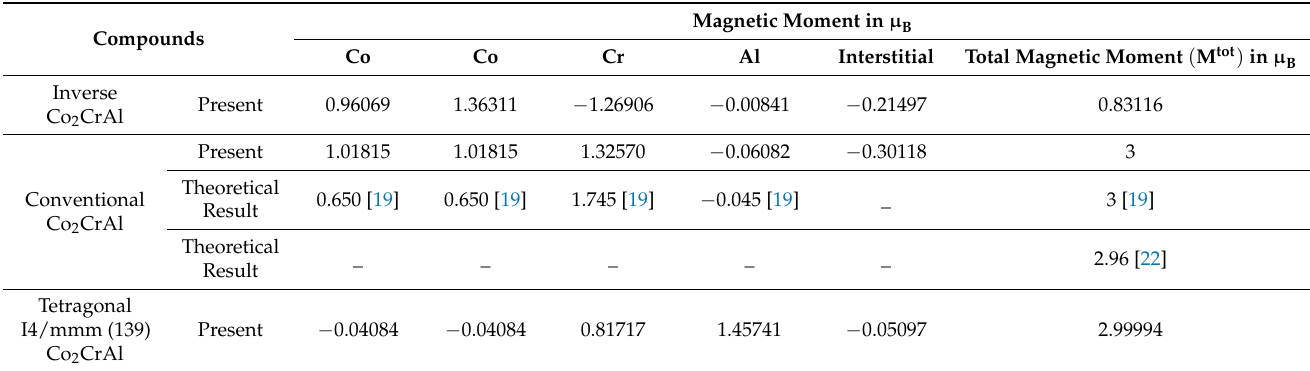
Table 3. Total magnetic moment for inverse, conventional and tetragonal I4/mmm (139) Heusler Co 2 CrAl compound.